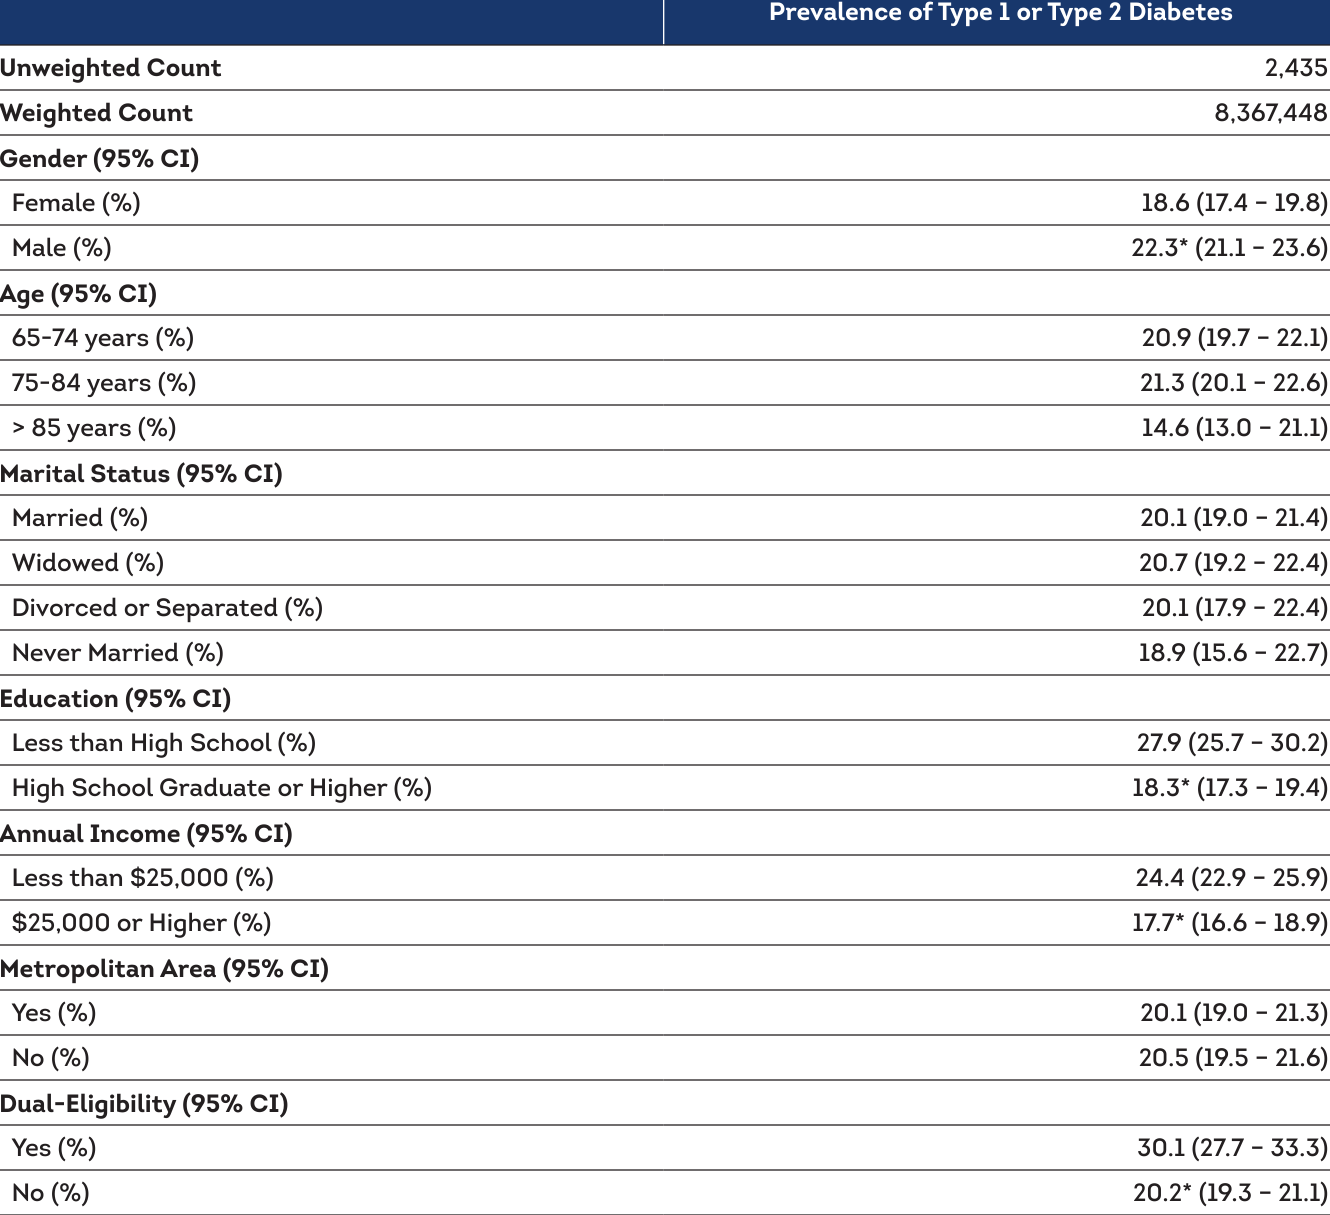
Table A2: Demographic and socioeconomic